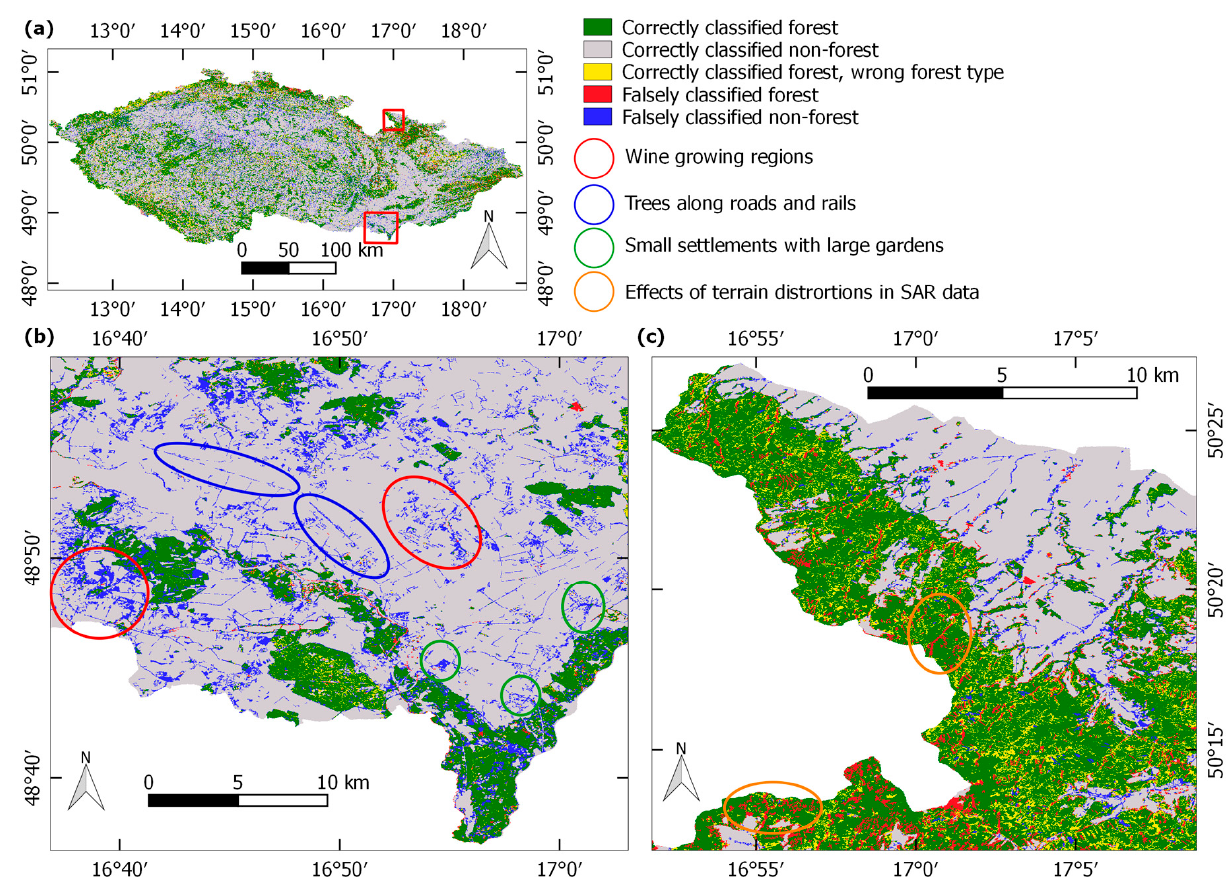
Figure 10. Common reasons of disagreement between the Sentinel-1 and reference Copernicus High Resolution Layers forest maps (Indicated by ellipses). ( a ) Difference map between the Sentinel-1 and Copernicus forest type map over Czech Republic, ( b ) detail of the difference map over area in flatland and ( c ) detail of the difference map over area in mountains.